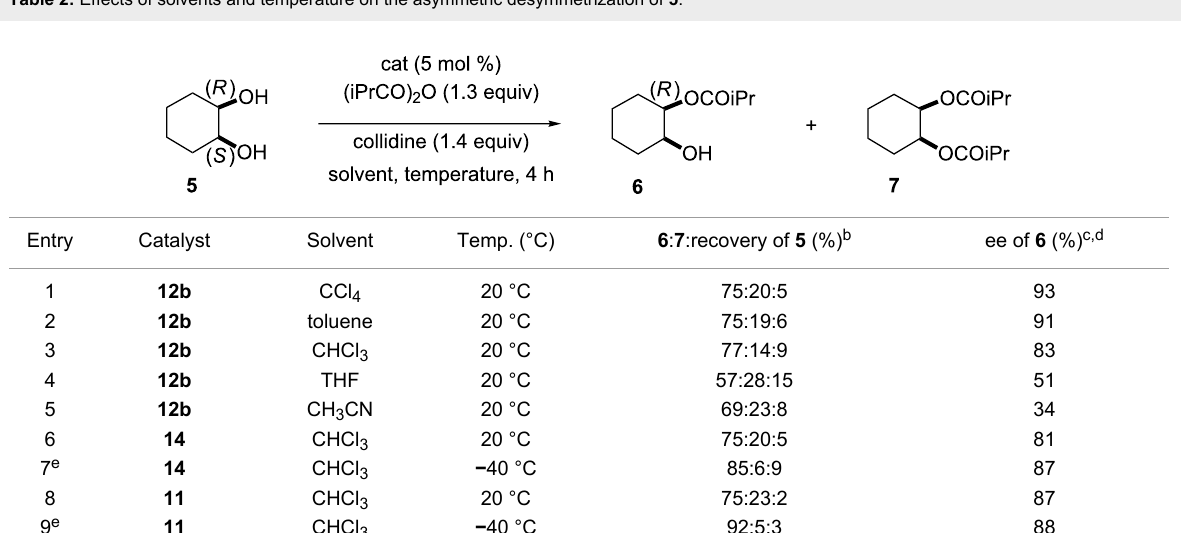
Table 2: Effects of solvents and temperature on the asymmetric desymmetrization of 5 . a